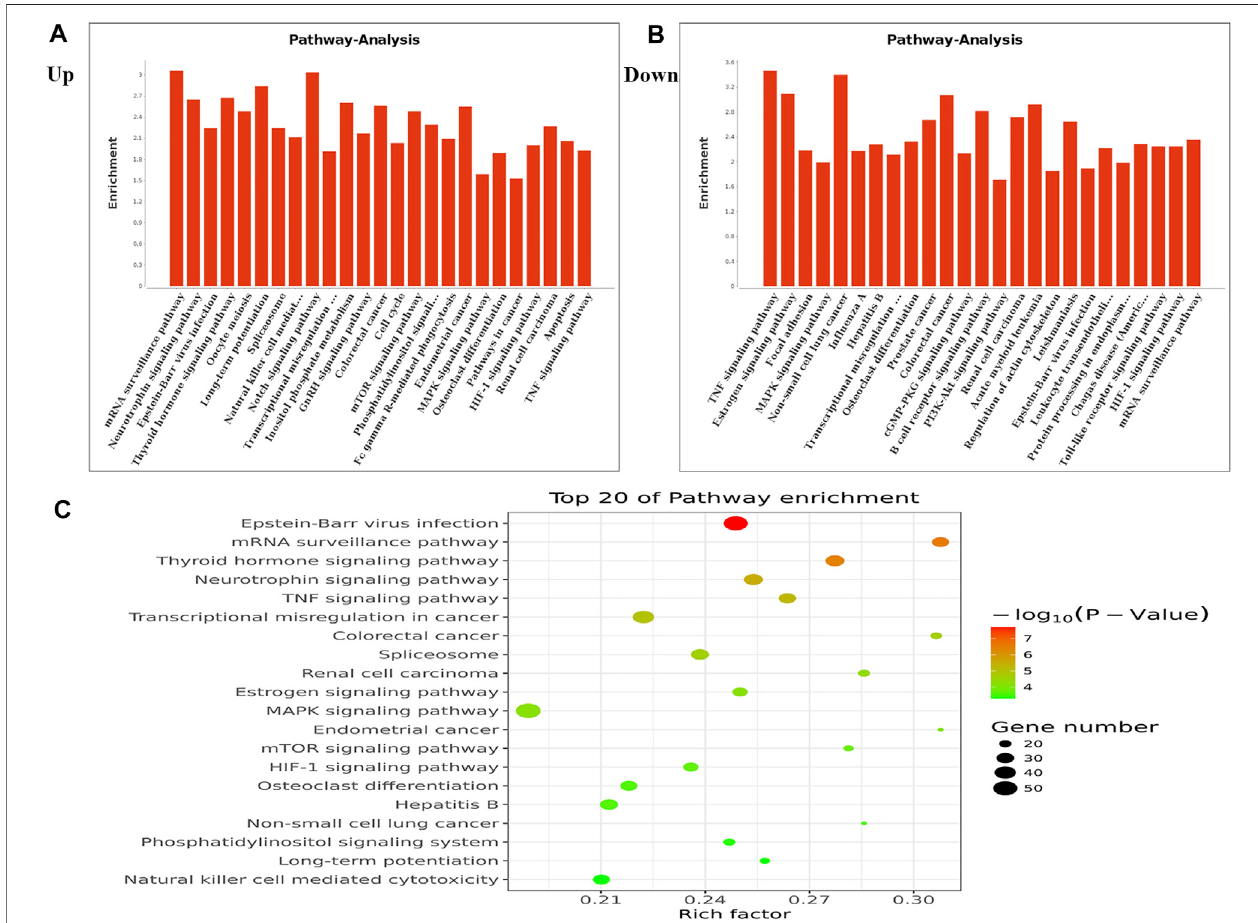
FIGURE 3 | KEGG pathway and Enrichment analysis of differential m 6 A peaks. (A) The top ten enrichment pathway terms related to mRNAs with increased methylation are shown; ( − log10p) for signi fi cance. The log-transformed results were used for visualization. (B) The top ten enrichment pathway terms related to mRNAs with decreased methylation; ( − log10p) for signi fi cance. The log-transformed results were used for visualization. (C) The KEGG bubble shows the top 20 enrichment pathway terms related to methylated mRNAs.